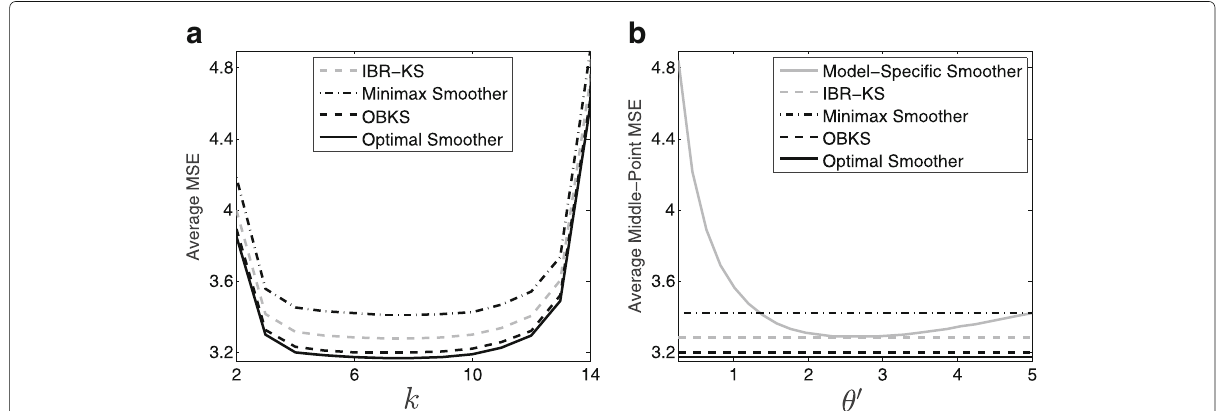
Fig. 2 Performance comparison of different Kalman smoothers for the target tracking example with unknown r . a Average MSE across the observation window. b Average middle-point MSE ( k = 8). θ (cid:7) gives the value at which the model-specific smoother is